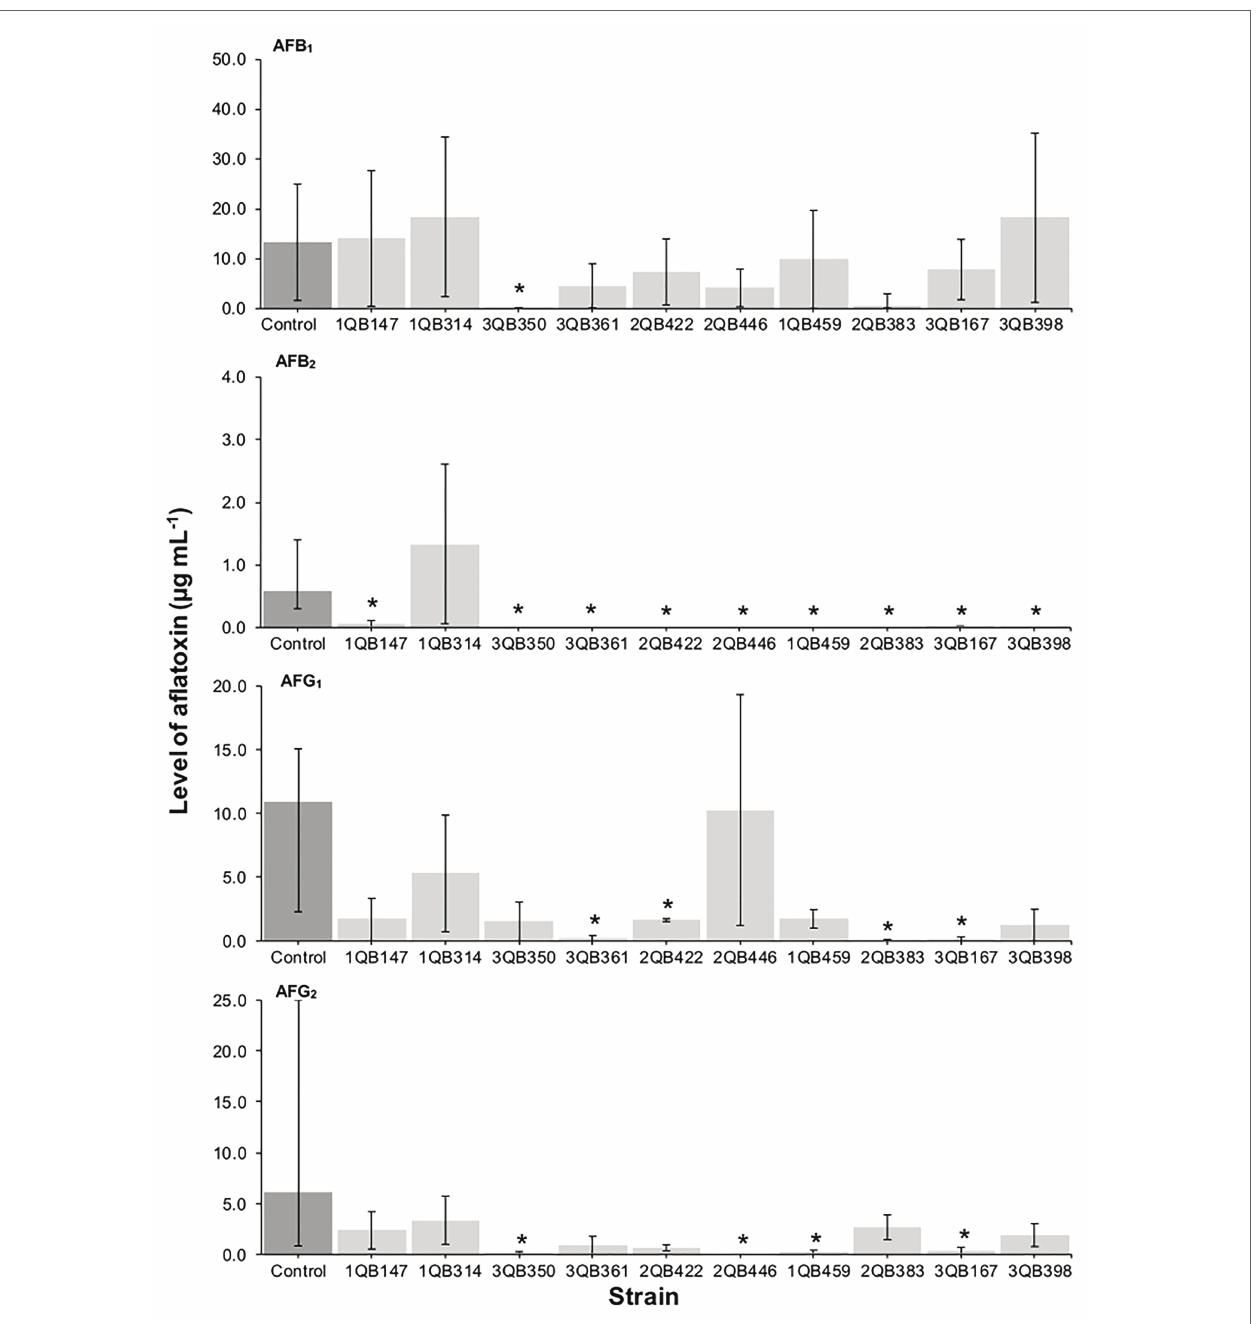
FIGURE 1 | Effect of LAB on production of aflatoxins B 1 (AFB 1 ), B 2 (AFB 2 ), G 1 (AFG 1 ), and G 2 (AFG 2 ), by A. parasiticus NRRL 2999 in co-cultured YES broth after 7 days of incubation at 25 ° C. LAB was inoculated (5.0 log 10 cfu ml −1 ) simultaneously with the fungus (Inoculation = T 0 h). The individually tested LAB included: four strains of Lactiplantibacillus plantarum (former Lactobacillus plantarum , comprising strains 1QB147, 1QB314, 3QB350, and QB361), two strains of Levilactobacillus brevis (former Lactobacillus brevis , comprising strains 2QB422 and 3QB446), and four strains of Levilactobacillus spp. (former Lactobacillus sp., comprising strains 1QB4593, 2QB383, 3QB167, and QB398). Results are expressed as median values of three independent experiments, with minimum and maximum values indicated as error bars. *Median values with asterisks differ significantly from controls ( p <